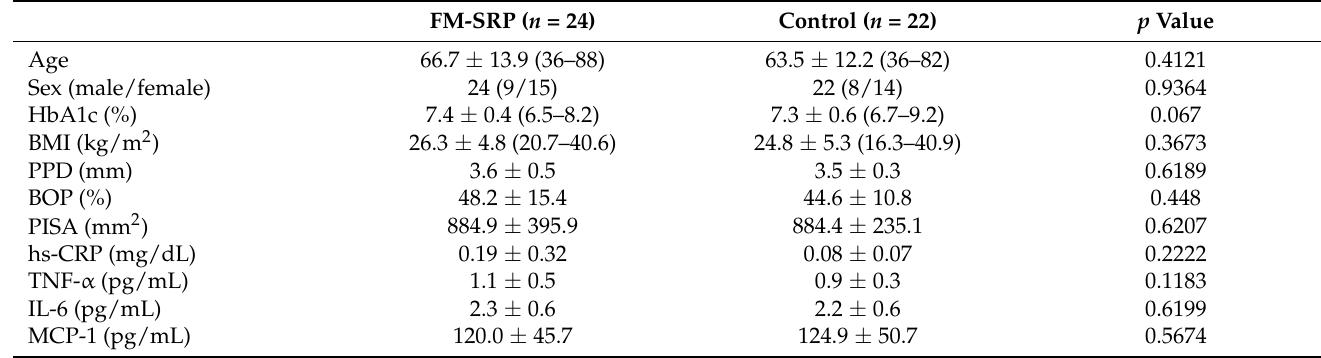
Table 1. BL values.